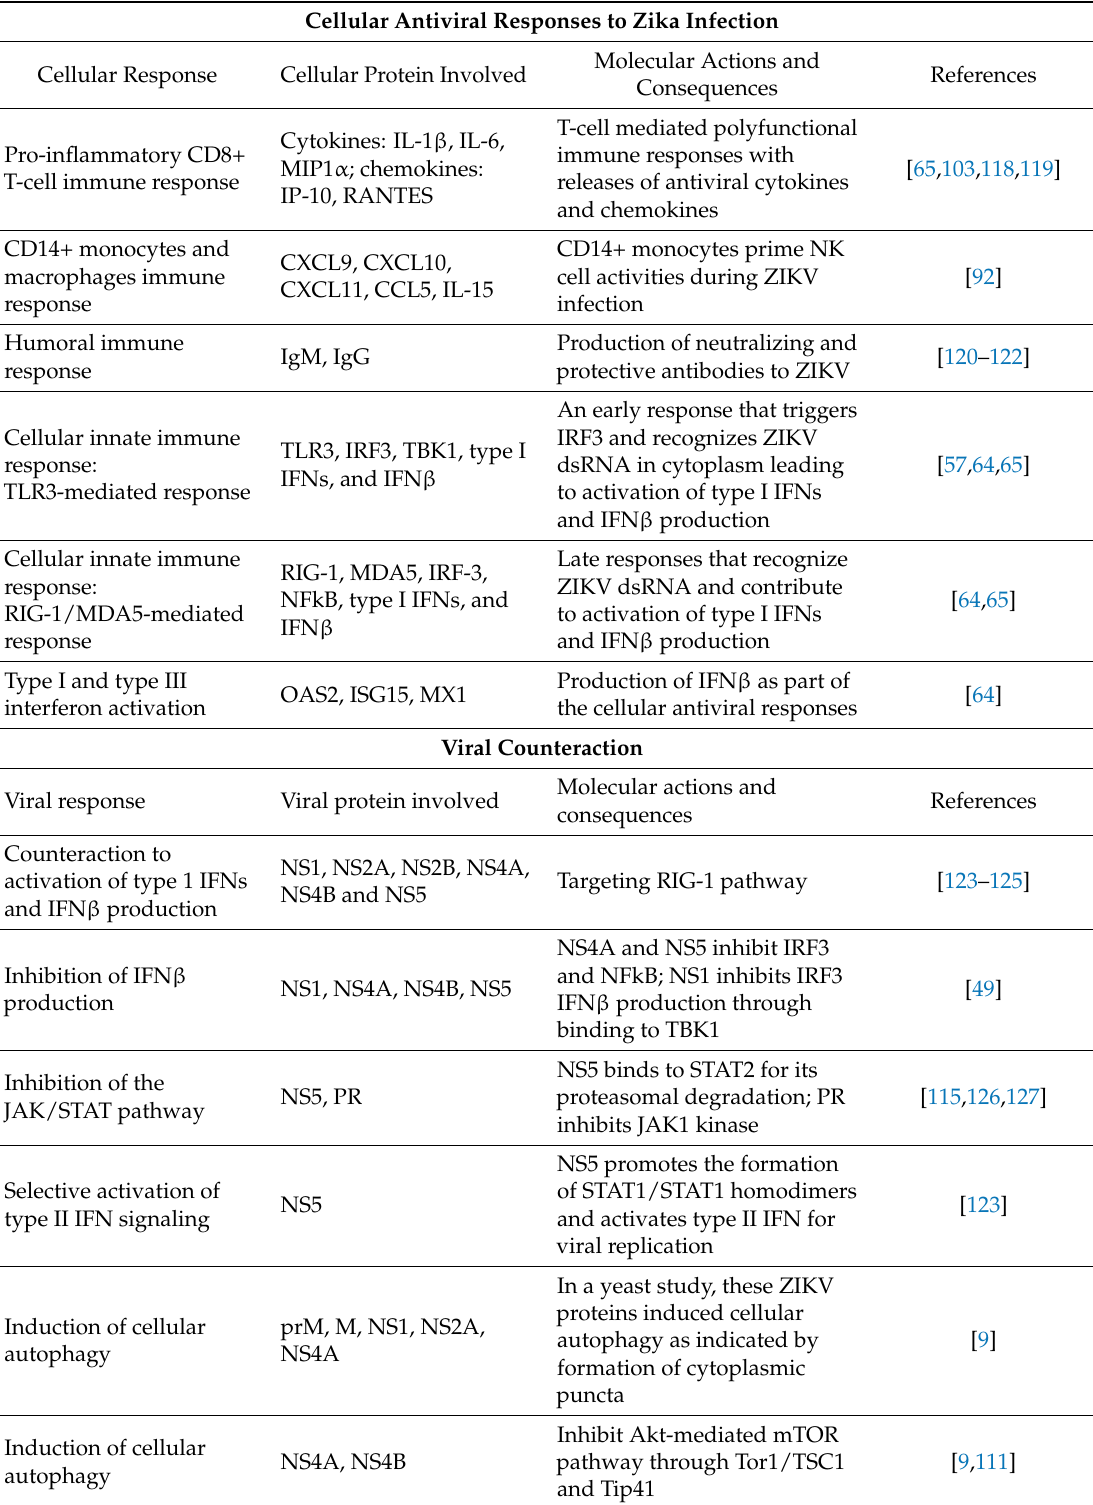
Table 3. Cellular antiviral responses and viral counteractions during Zika